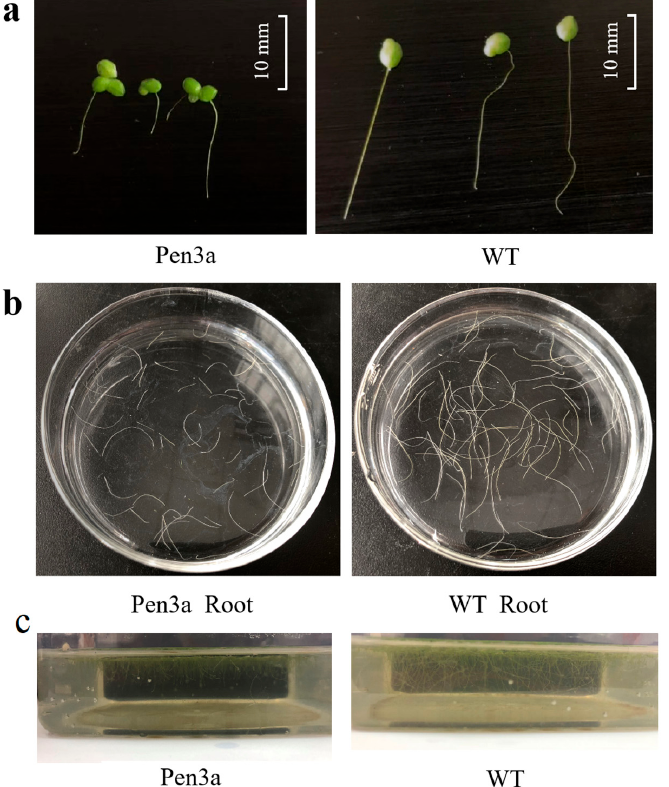
Figure 3. The phenotype of duckweed cultured in aquaculture lake water for 14 days. ( a ) Difference of root length between WT and Pen3a duckweed after 14 days of culture. Scale bar = 10 mm; ( b ) root abscission rate of WT and Pen3a duckweed; ( c ) Pen3a and WT water body conditions after 14 days of culture in the same cultured aquaculture